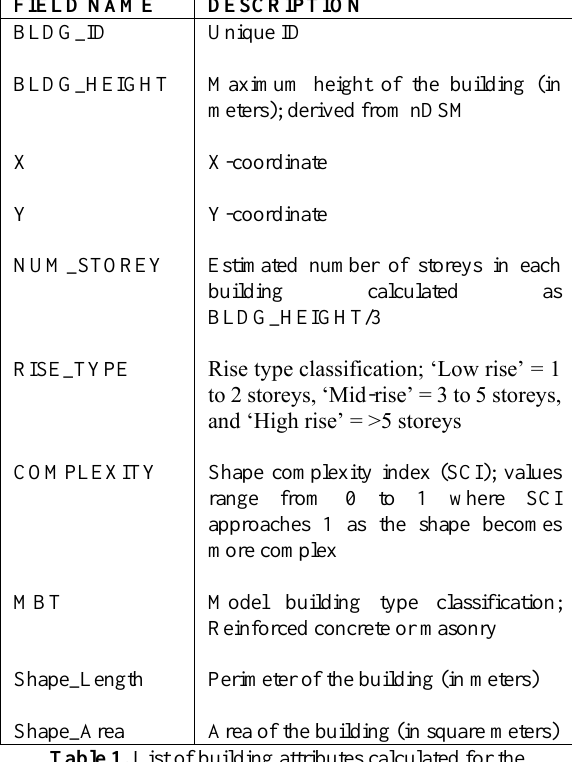
Table 1. List of building attributes calculated for the earthquake exposure database.